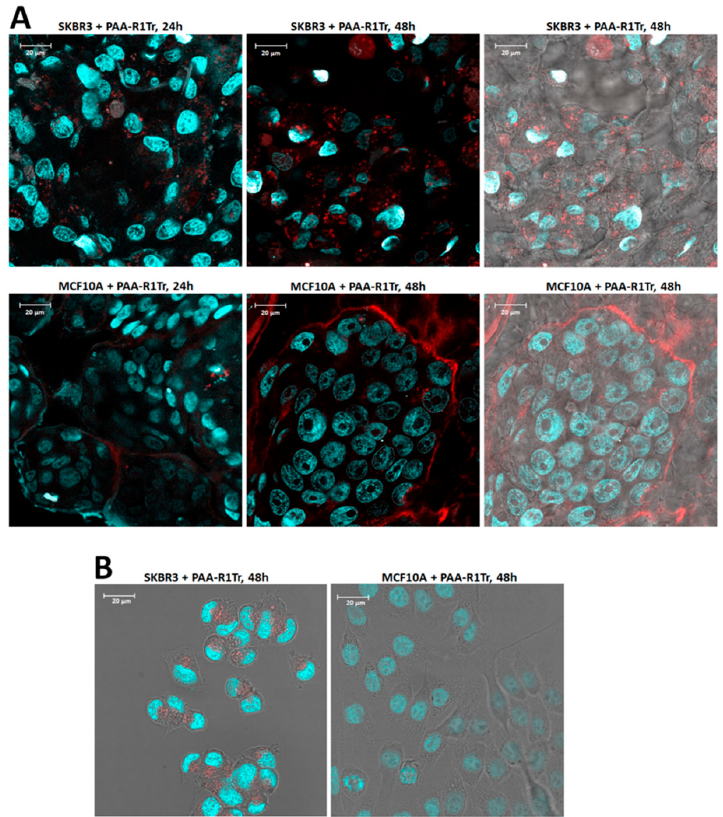
Figure 6. Panel ( A ): Images of SKBR3 spheroids (top row) and MCF10A spheroids (bottom row) incubated with truncated SKBR3-R1Tr-AF594 aptamers on polyacrylamide (1:225). Spheroids in the images on the left were incubated for 24 h with aptamer polymers and spheroids in the middle images for 48 h. The images on the right include the bright field images of the 48 h incubations. Panel ( B ): Images of SKBR3 cells (left) and MCF10A cells (right) grown in 2D in chamber slides, incubated with truncated SKBR3-R1Tr-AF594 aptamers on polyacrylamide (1:225). Cells were incubated for 48 h with aptamers and images were acquired at 100× magnification.